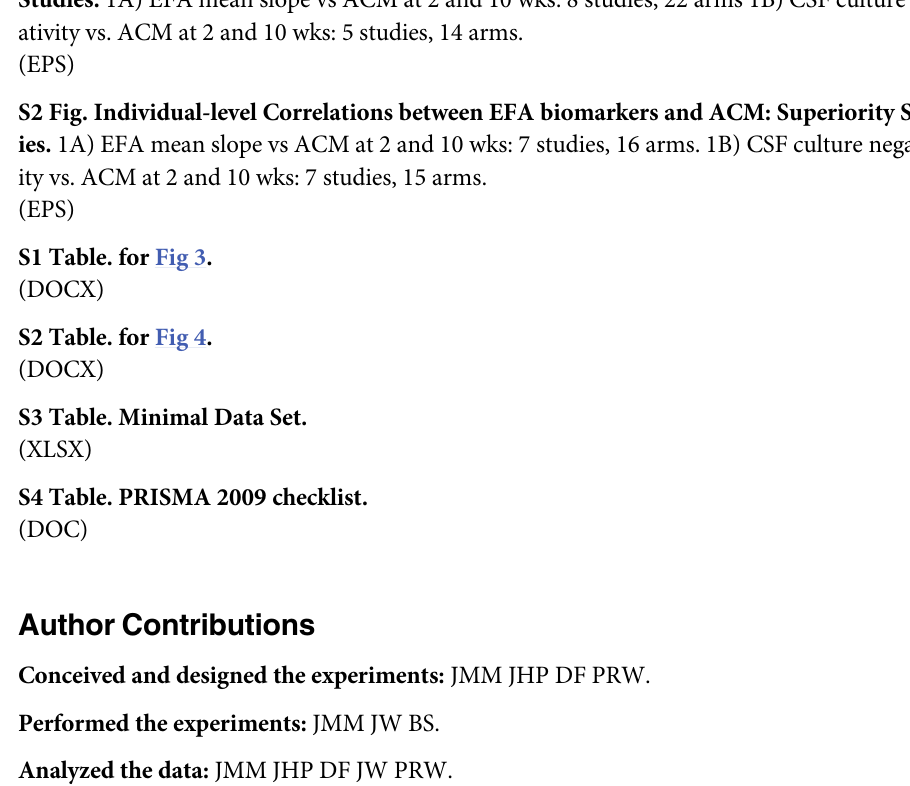
S1 Fig. Individual-level Correlations between EFA biomarkers and ACM: High Quality Studies. 1A) EFA mean slope vs ACM at 2 and 10 wks: 8 studies, 22 arms 1B) CSF culture neg- ativity vs. ACM at 2 and 10 wks: 5 studies, 14 arms. S2 Fig. Individual-level Correlations between EFA biomarkers and ACM: Superiority Stud- ies. 1A) EFA mean slope vs ACM at 2 and 10 wks: 7 studies, 16 arms. 1B) CSF culture negativ- ity vs. ACM at 2 and 10 wks: 7 studies, 15 arms. S1 Table. for Fig 3. S2 Table. for Fig 4. S3 Table. Minimal Data Set. S4 Table. PRISMA 2009